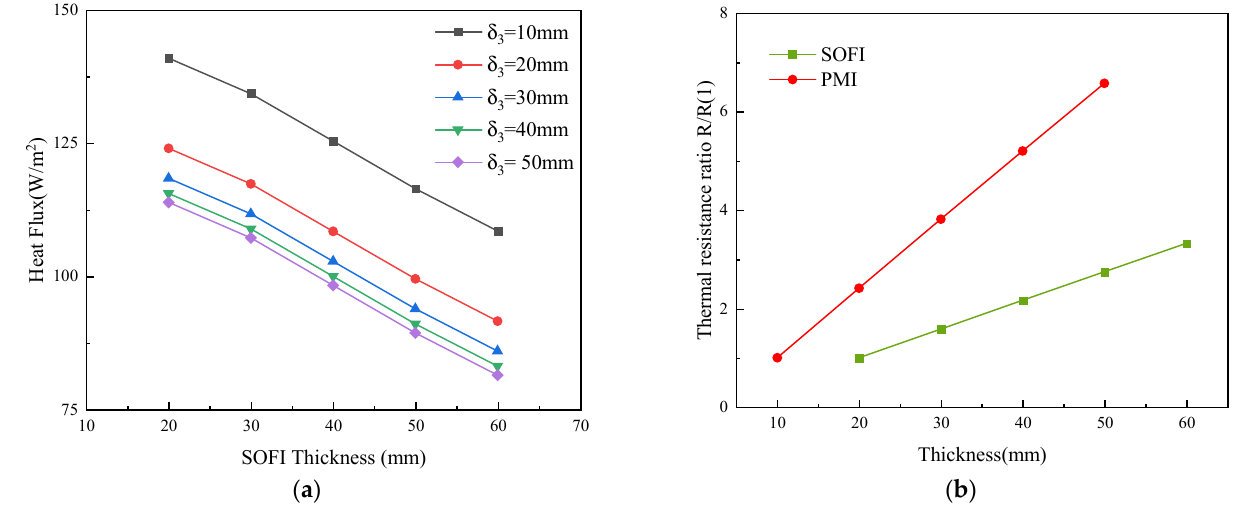
Figure 6. Insulation performance of different thickness for SOFI and PMI: ( a ) heat flux of different SOFI thicknesses; ( b ) thermal resistance K of different thermal insulation material thickness compared with the thermal resistance of the fi rst thickness.